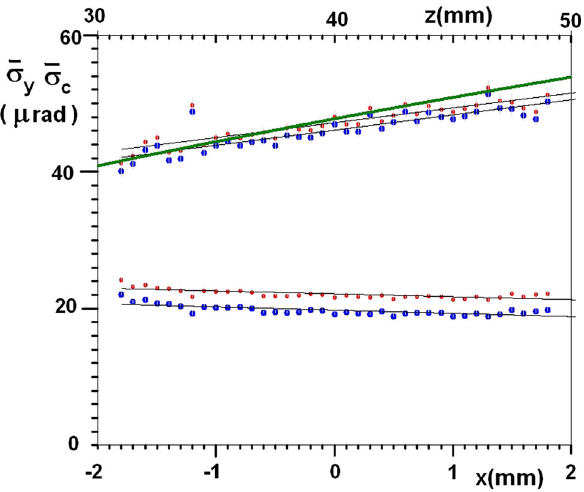
Fig. 6 The σ y and σ c values as functions of the distance along crystal 4 (from 30 mm up to 50 mm). The beam momentum is 180 GeV/c. The lower horizontal scale is the transverse coordinate x and the upper scale is the corresponding longitudinal coordinate z . The red and blue points correspond to uncorrected and corrected (due to background) results. The upper points correspond to σ y -values and lower points cor- respond to σ c -values. The green curves are calculations accordingly to Eq. (4). The black thin lines are linear approximations of corresponding